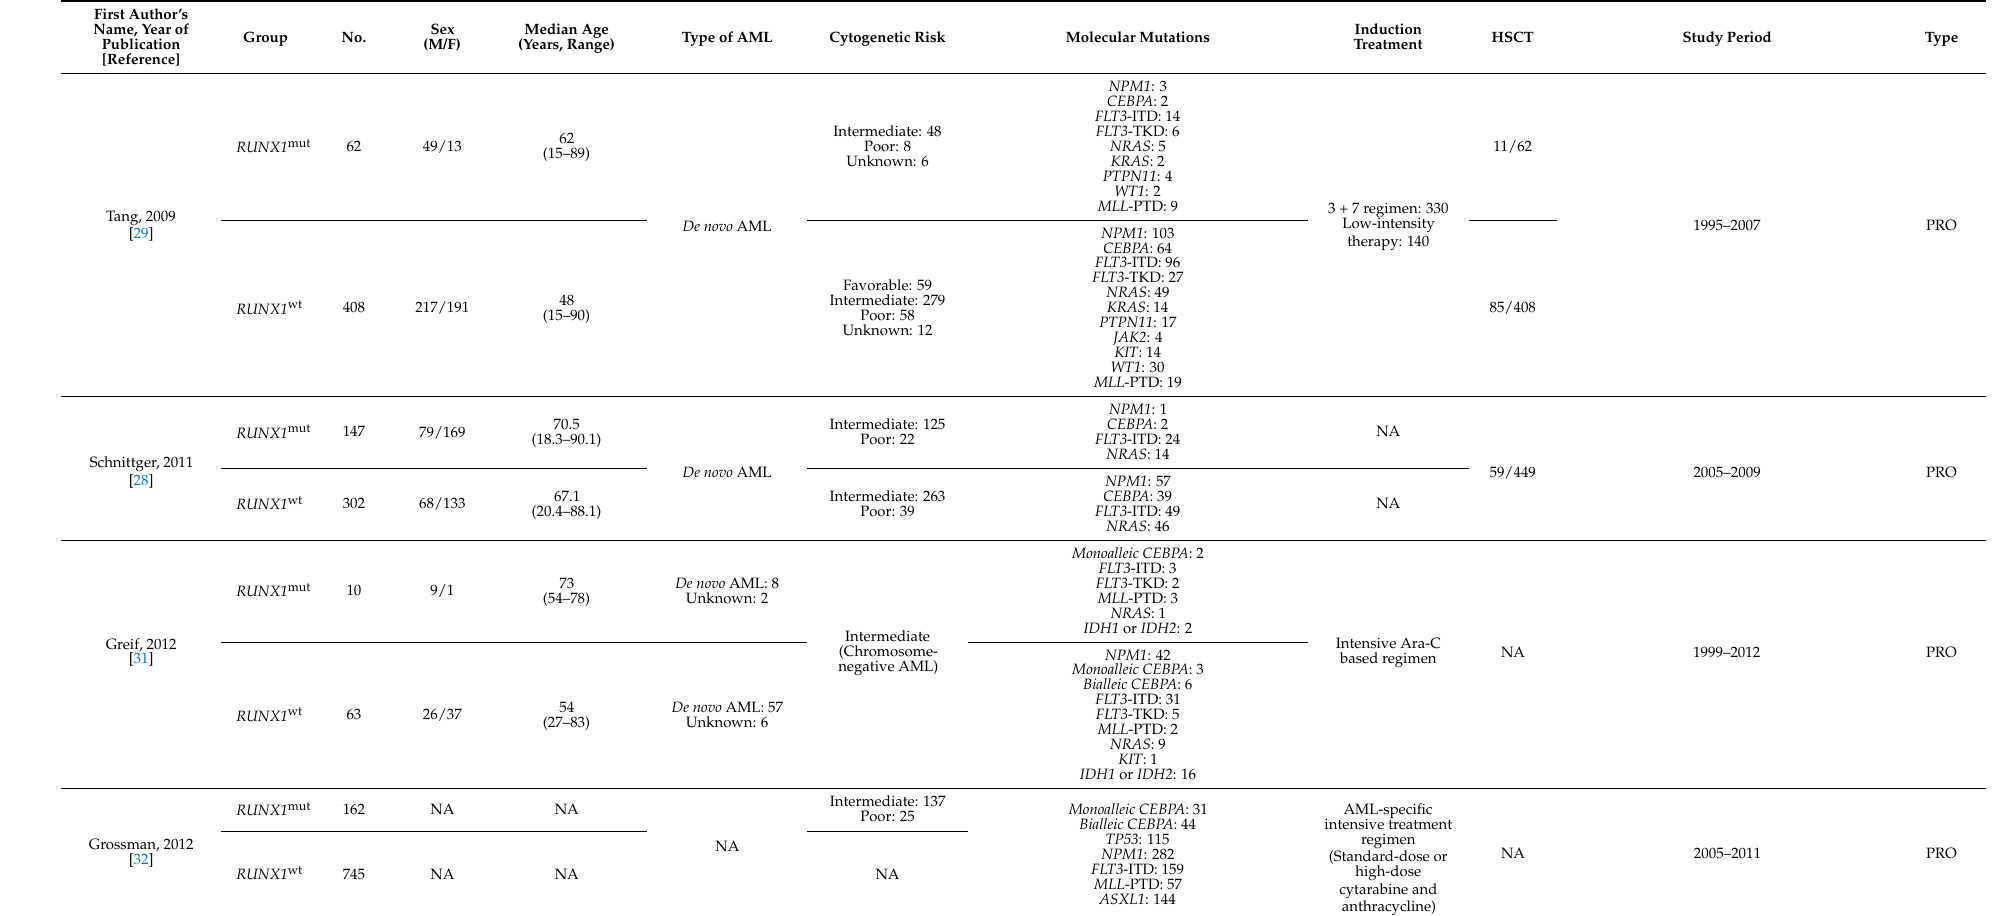
Table 3. Patients’ baseline characteristics for studies included in the